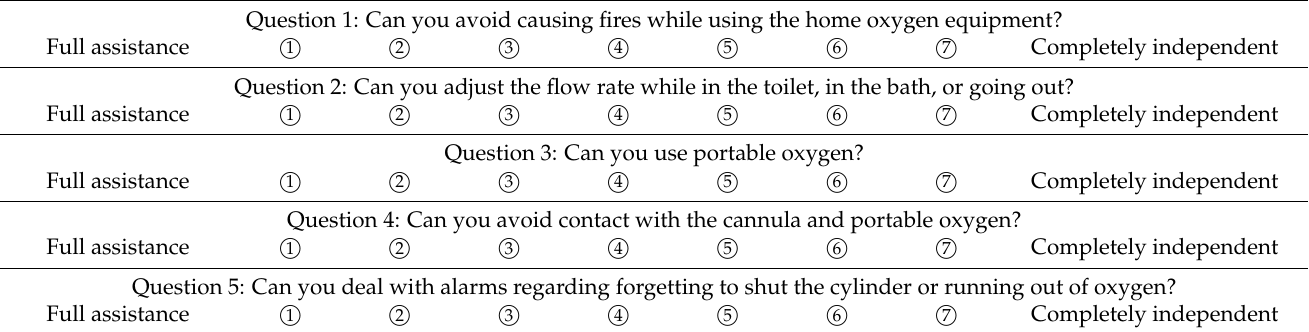
Table 2. The survey of long-term oxygen therapy equipment operation ability drafted for this